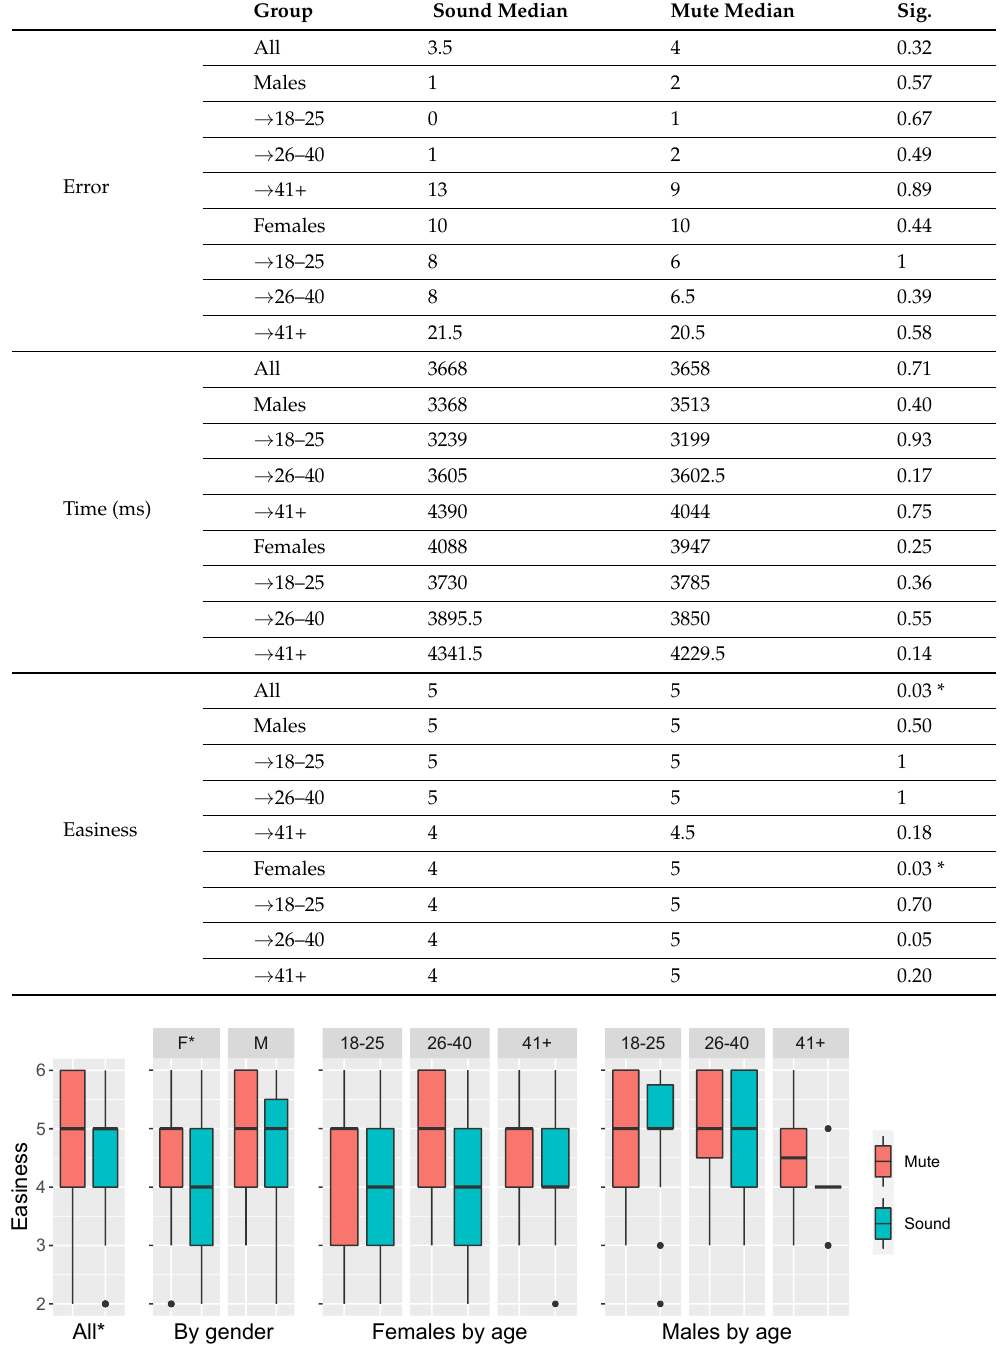
Figure 6. Boxplots showing ease of synchronization by comparing “Mute” and “Sound” conditions for (1) all participants, (2) by gender, and (3) by genders and age. Significant differences are marked with